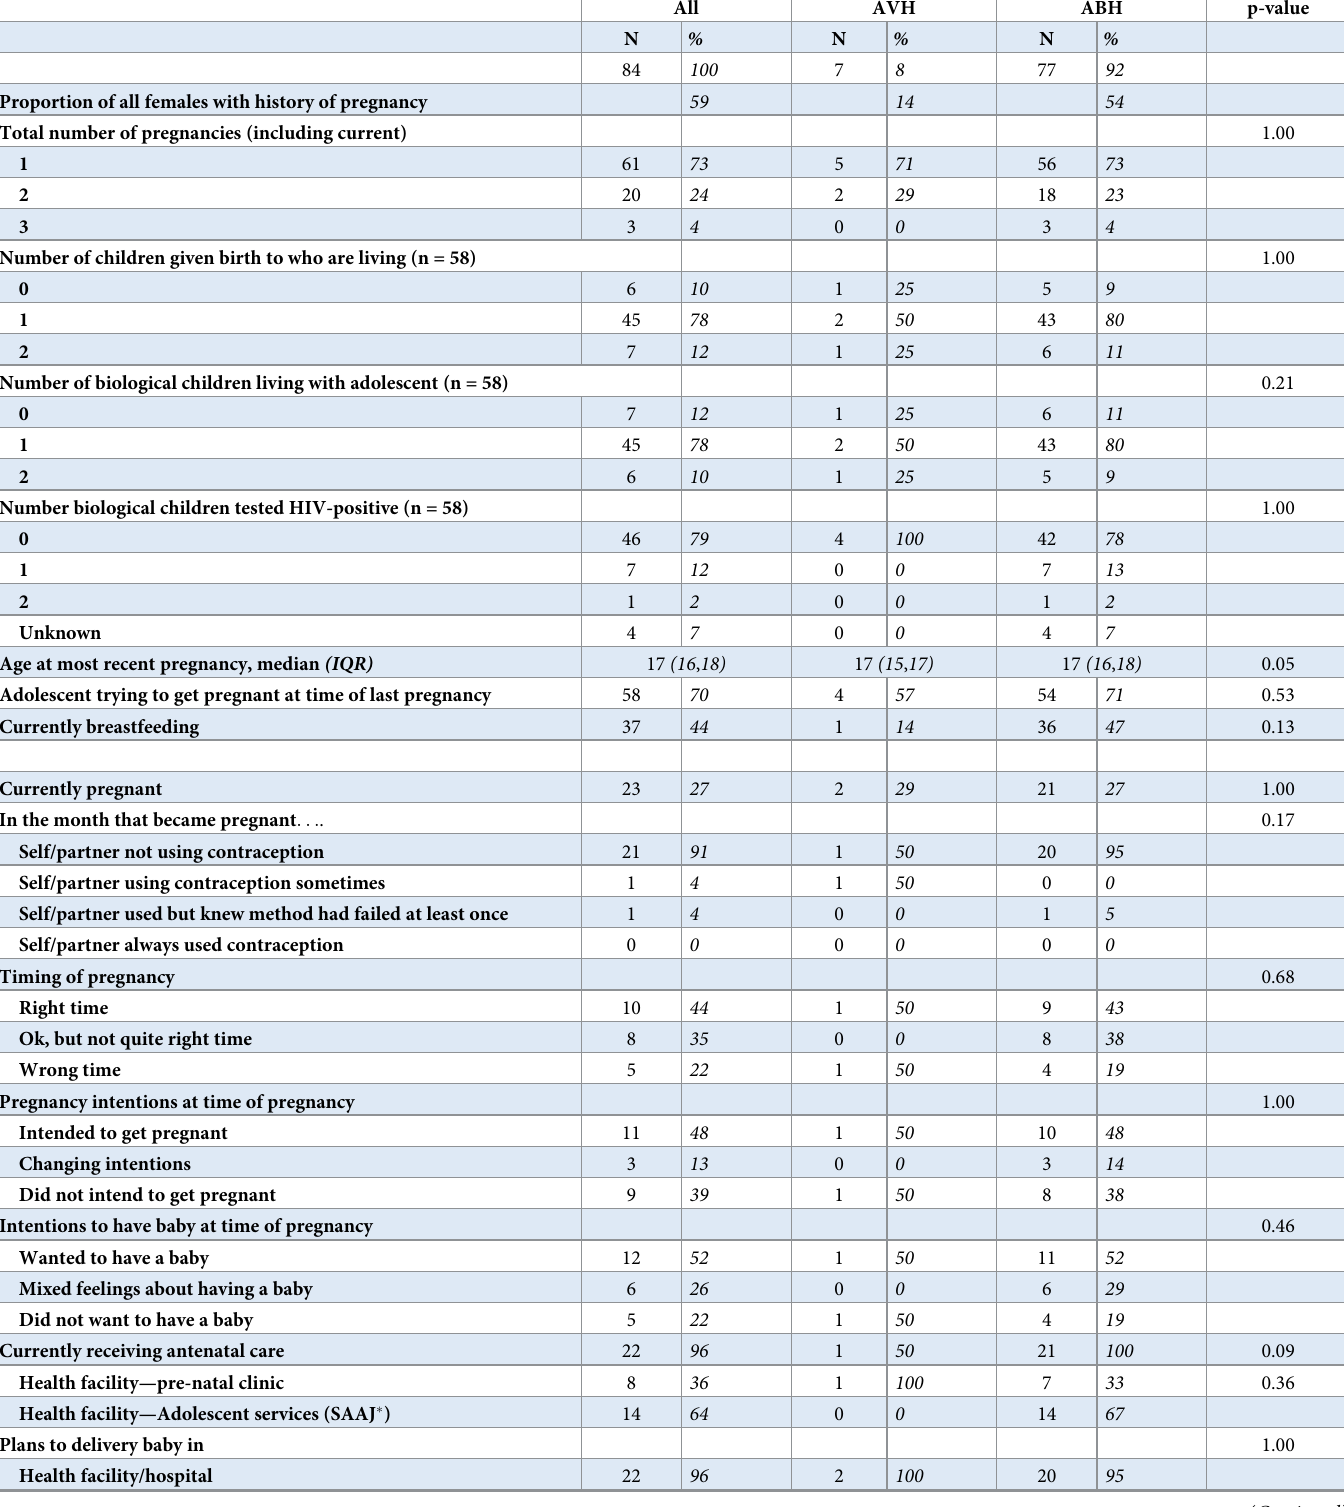
Table 5. Pregnancy status and history among female ALHIV 15–19 years of age in Mozambique who had ever been pregnant (N = 84).